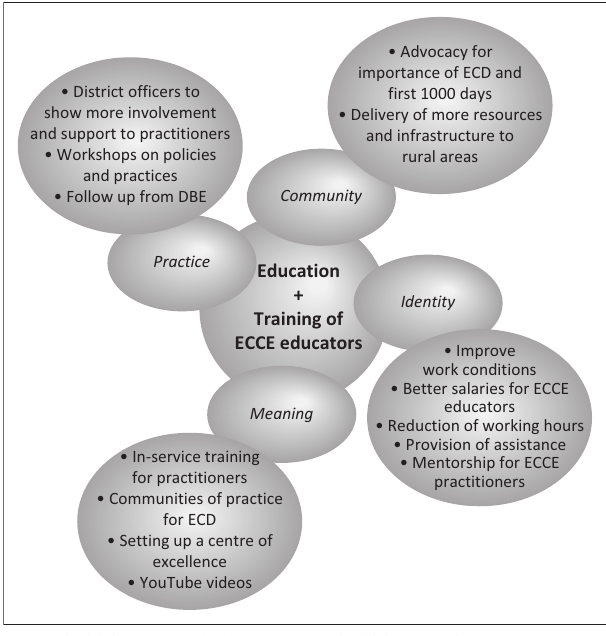
FIGURE 2: Pam Zulu’s model of enhancing early childhood care and education practitioners’ education and